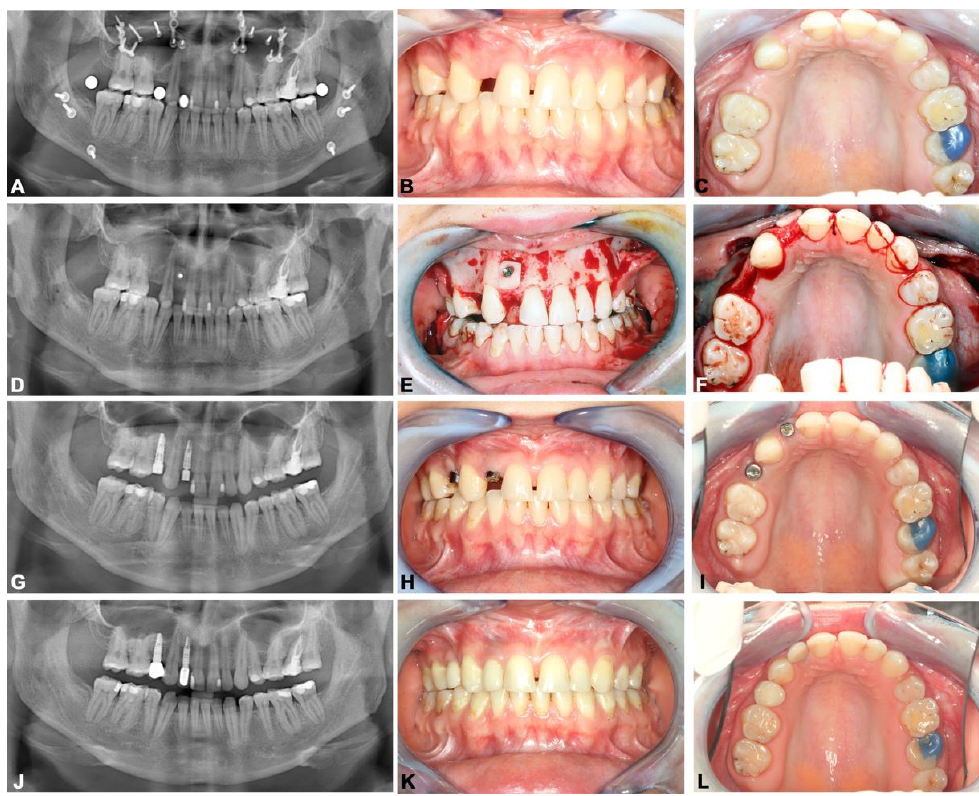
Figure 2. Dental rehabilitation of patient with hypodontia. ( A – C ) Panoramic radiograph and intraoral photos showing the situation after orthognathic surgery and teeth gaps in the left maxillary: first premolar and lateral incisor region. ( D – F ) Panoramic radiograph and intra-operative photos showing bone augmentation in the left maxillary lateral incisor region. ( G – I ) Panoramic radiograph and intraoral photos after the exposure of the implants. ( J – L ) Panoramic radiograph and intraoral photos after 54 months of prosthetic rehabilitation.